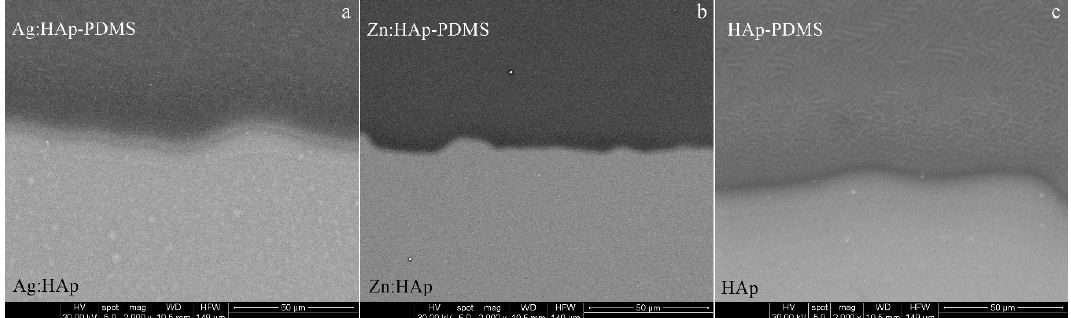
Figure 2. The SEM images of the interface zone between: ( a ) Ag:HAp-PDMS (darker zone) and Ag:HAp (lighter zone); ( b ) Zn:HAp-PDMS (darker zone) and Zn:HAp (lighter zone); ( c ) HAp-PDMS (darker zone) and HAp (lighter zone).